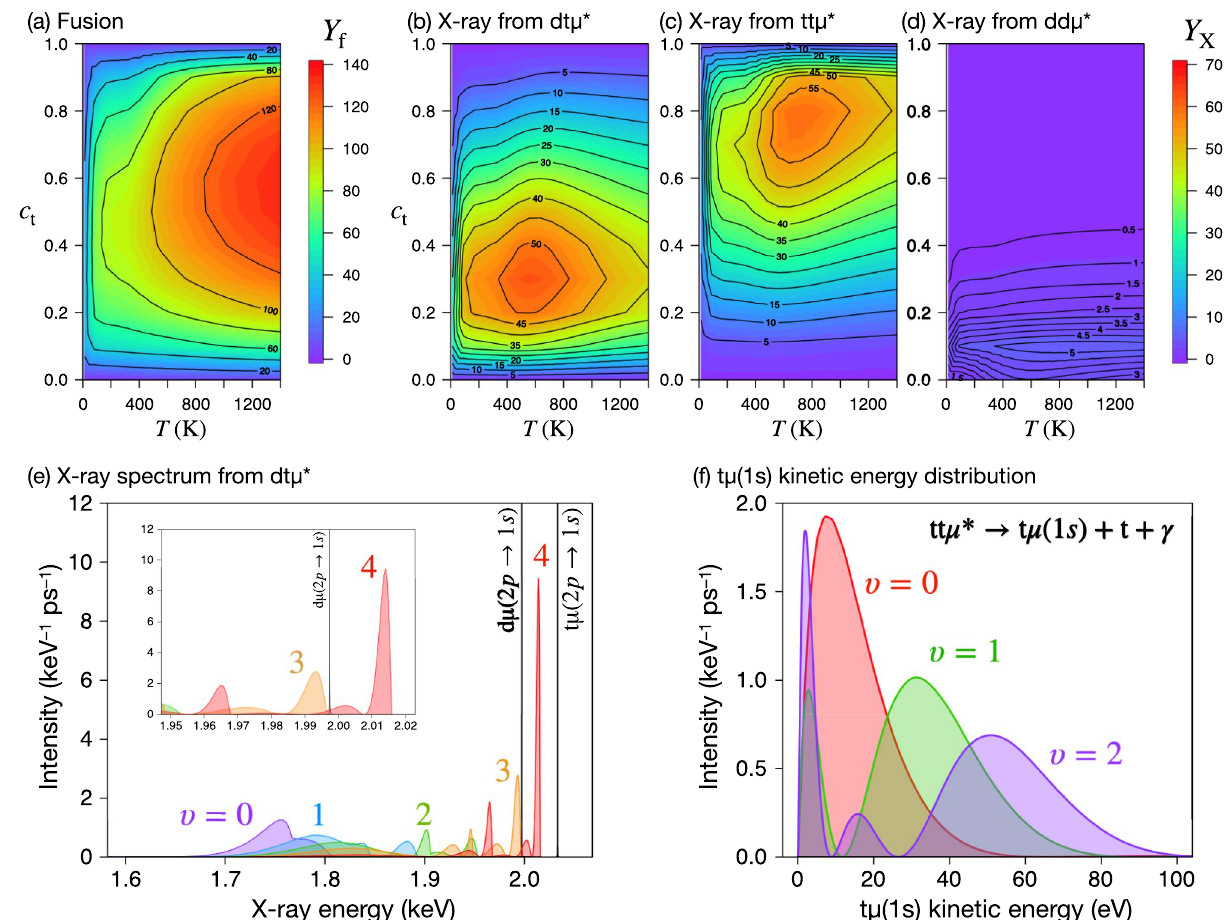
Figure 5. Fusion ( a ) and X-ray ( b )–( d ) yields as functions of tritium concentration and temperature under the ϕ = 1 condition. ( e ) X-ray spectrum of dt µ ∗ in the υ -th vibrational states (the colors indicate 0 ≤ υ ≤ 4 ) 86 . The black narrow lines indicate 2 p → 1 s X-rays of d µ (1.997 keV) and t µ (2.033 keV). The inset of ( e ) is a close-up view of the spectrum. ( f ) t µ( 1 s ) kinetic energy spectrum of radiative dissociation of tt µ ∗